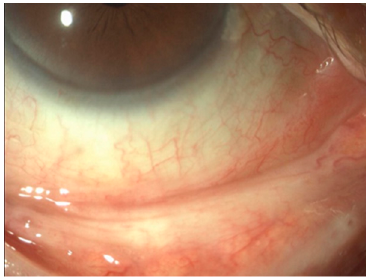
Figure 4. Normal appearance of conjunctiva 10 days postoperative.